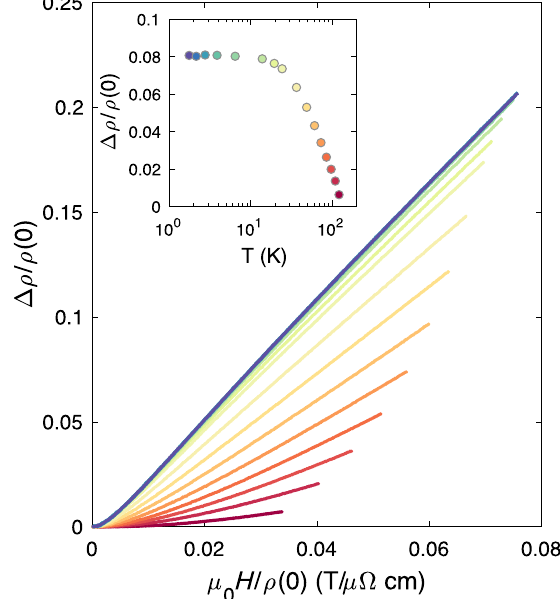
FIG. 3. Kohler ’ s rule in BaFe 2 As 2 . Relative magnetoresistance versus reduced field for different temperatures. The inset shows the temperature dependence of the relative MR at a reduced field of μ 0 H= ρ ð 0 Þ ¼ 0 . 03 T = μ Ω cm.